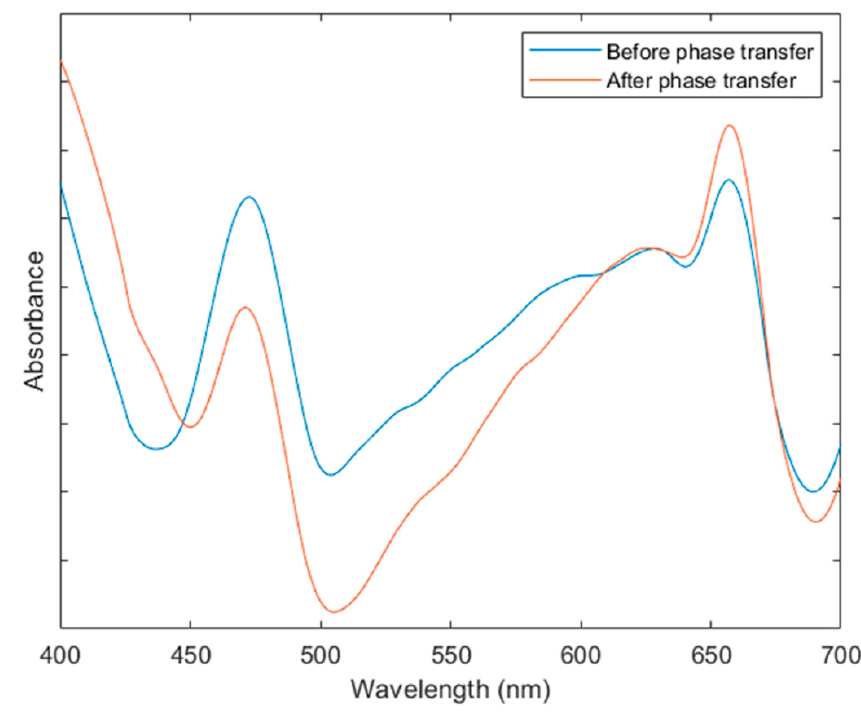
Figure 5. UV / Vis absorption spectrum of AgNSs before / after phase Figure 5. UV/Vis absorption spectrum of AgNSs before/after phase transfer